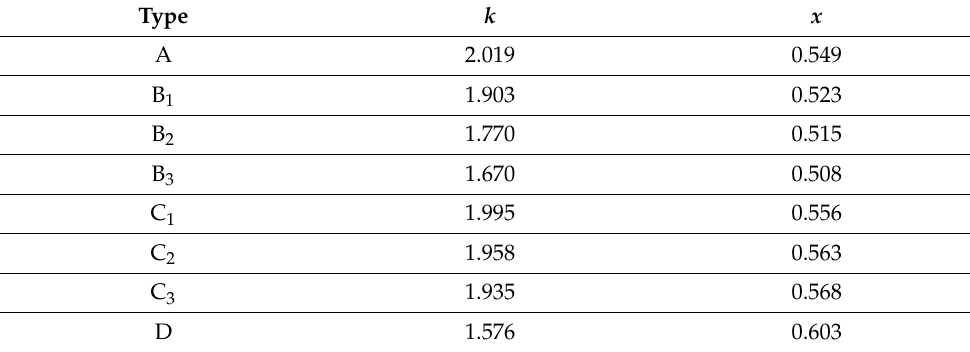
Table 3. Flow rate-pressure relationship of the emitter.